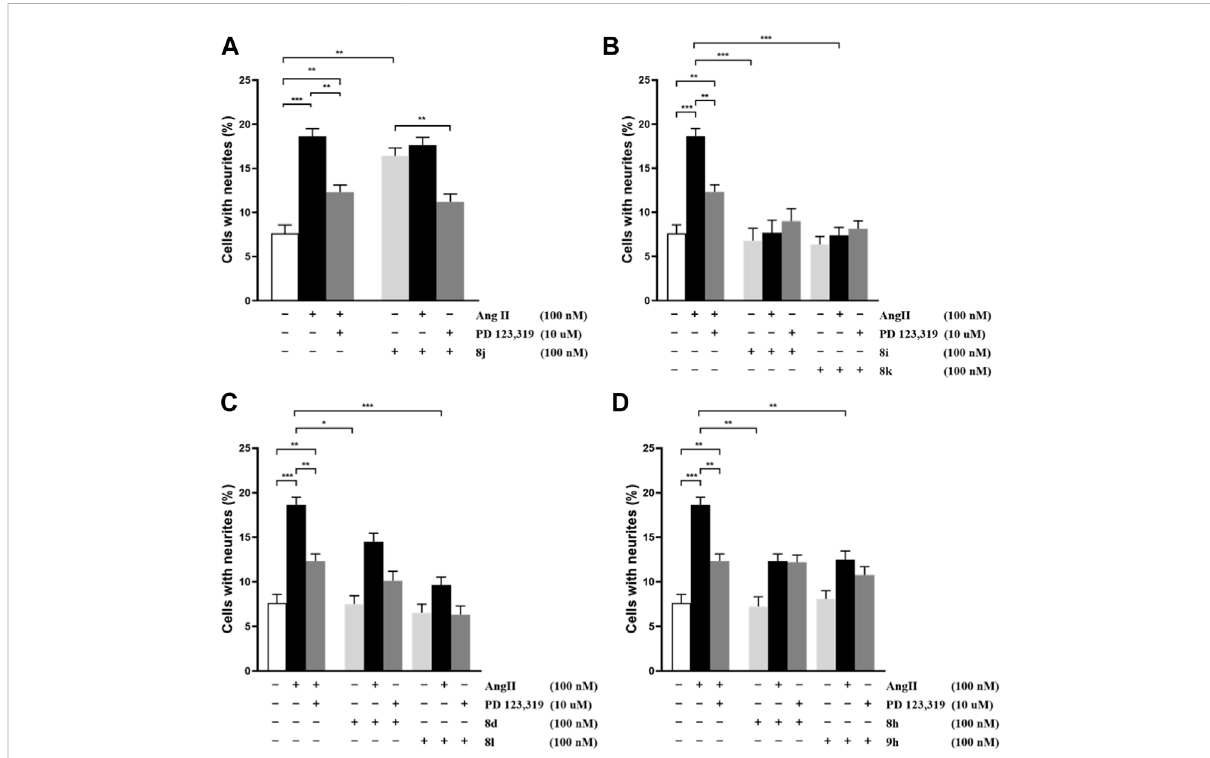
FIGURE 3 Effect of compounds 8j , 8i , 8k , 8d , 8l , 8h , and 9h on neurite outgrowth in NG108-15 cells. The number of cells with neurites was expressed as thepercentage of thetotal number in themicrographs (at least 400 cells per well plate according to theexperimental requirements). The results are signi fi cant according to two-way ANOVA: ***, p < 0.001; **, p < 0.01; *, p < 0.05; no signi fi cant difference is not